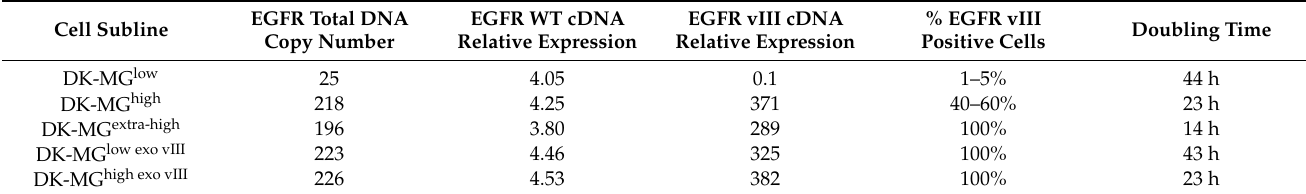
Table 2. Comparison of DK-MG sublines. EGFR wt and EGFR vIII expression was assessed by real- time PCR analysis in DK-MG sublines with endogenous (DK-MH low , DK-MG high , DK-MG extra-high ) and exogenous EGFR vIII expression (DK-MG low exovIII and DK-MG high exovIII ). The percentage of EGFR vIII -positive cells was estimated according to immunocytochemical staining performed on total EGFR and EGFR vIII . Doubling time was assessed by